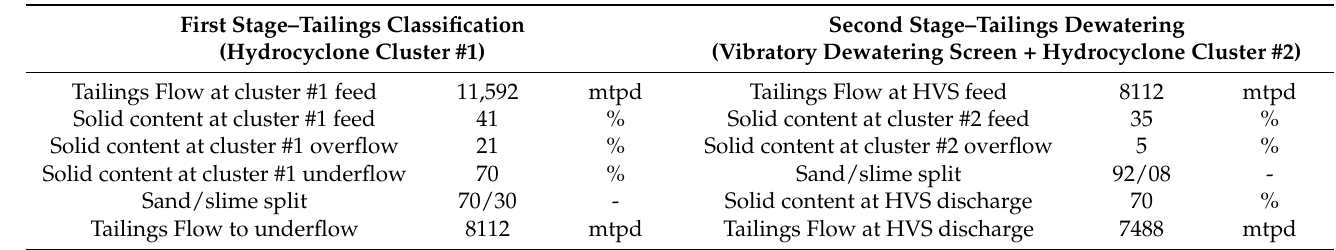
Table 2. Process Performances and Results–2nd Tailings Dewatering Industrial Plant (HC-HVS).